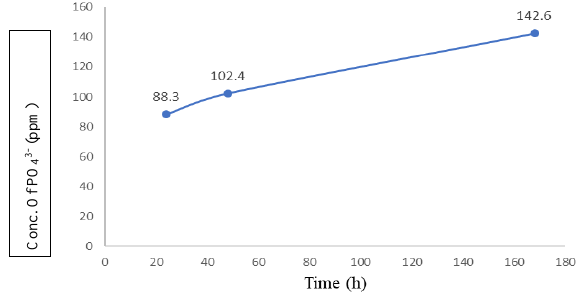
Figure 7: Release of phosphate ion from the kaolin–(NH 4 ) 2 HPO 4 Figure 7. Release of phosphate ion from the Kaolin–(NH 4 ) 2 HPO 4 system milled at 700 rpm system milled at 700 rpm for 2 for 2 h.